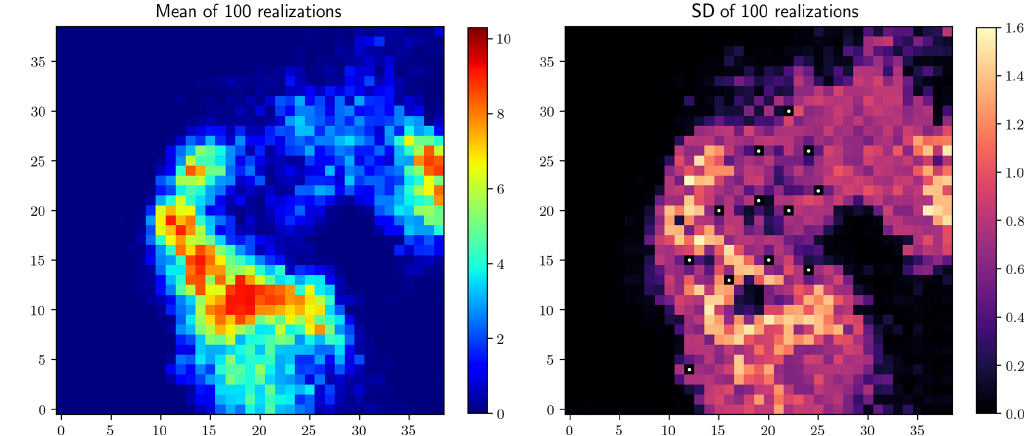
Figure 5. Stage 1 results: mean and standard deviation of 100 realizations (mm), obtained using the original quantile map as the